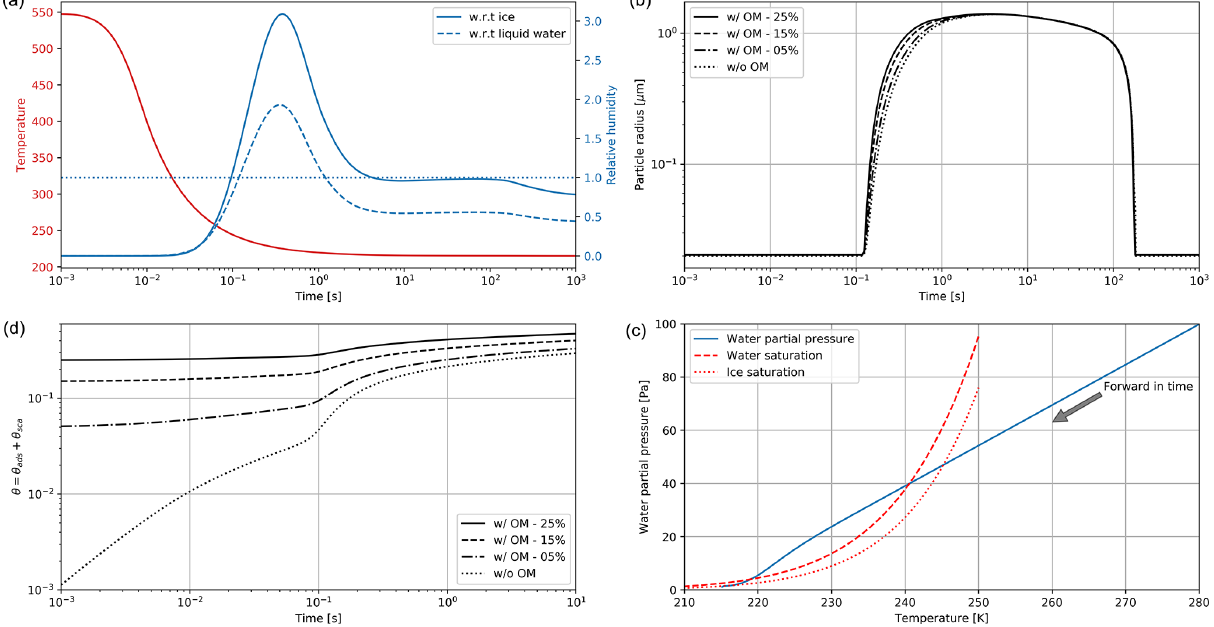
is prescribed), fuel